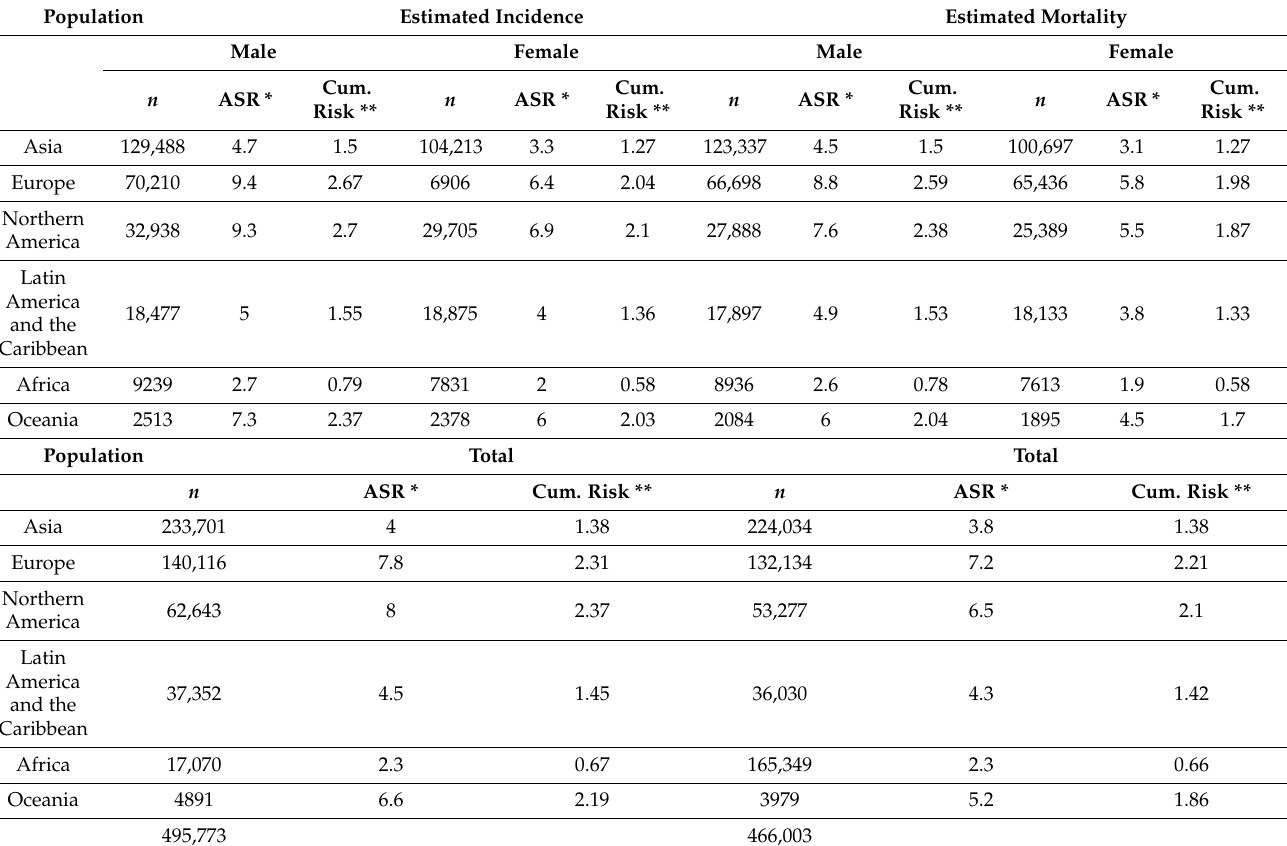
Table 1. Estimated pancreatic cancer incidence and mortality rates by continent and sex in 2020. Adapted from: GLOBOCAN,